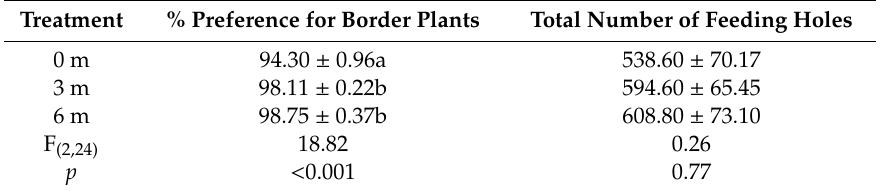
Table 3. Mean percentage feeding preference for border plants and total number of feeding holes in both border and ‘inner’ plants. Means are displayed with ± SEs. n = 10 for all means. Means with different letters (a–b) denote significant differences between treatments within a column.